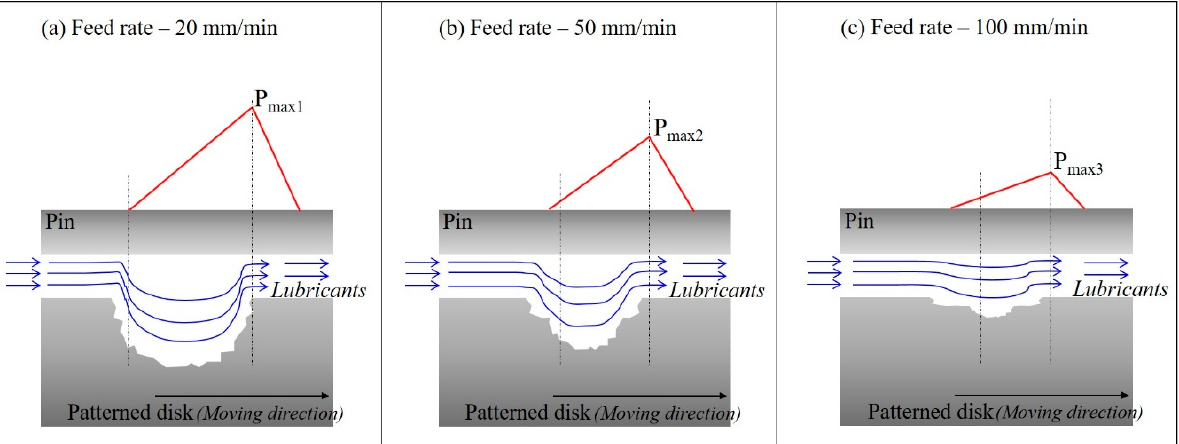
Figure 14. Mechanism showing the difference in the friction reduction effect according to the pattern change.